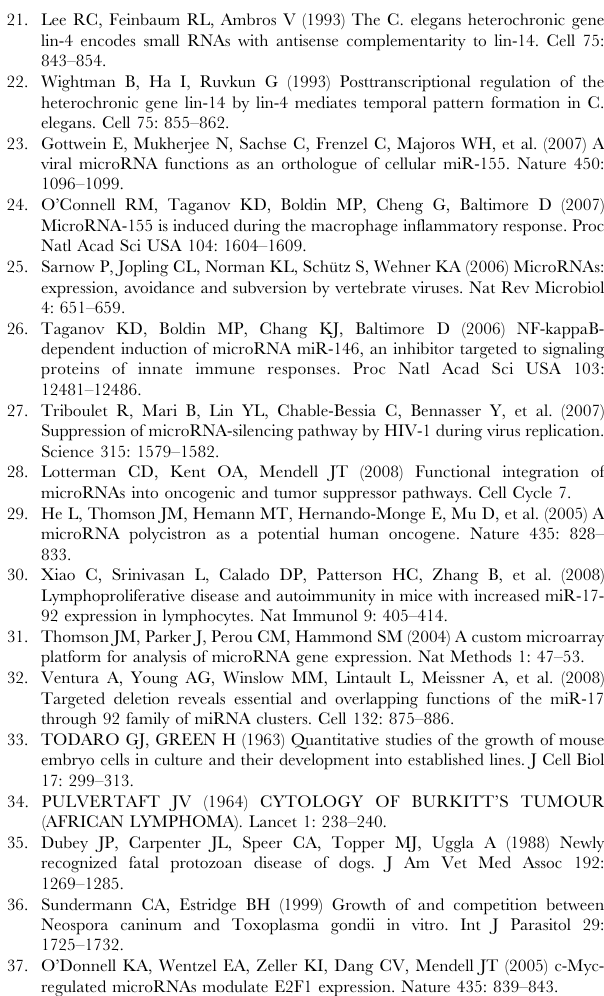
Figure S3 Probe sequences used in this study. All oligonucleo- tides are listed from 5 9 to 3 9 . In ‘notes’ column, target nucleotide positions are provided for all primer-extension probes. The forward and reverse primers used in PCR amplification of